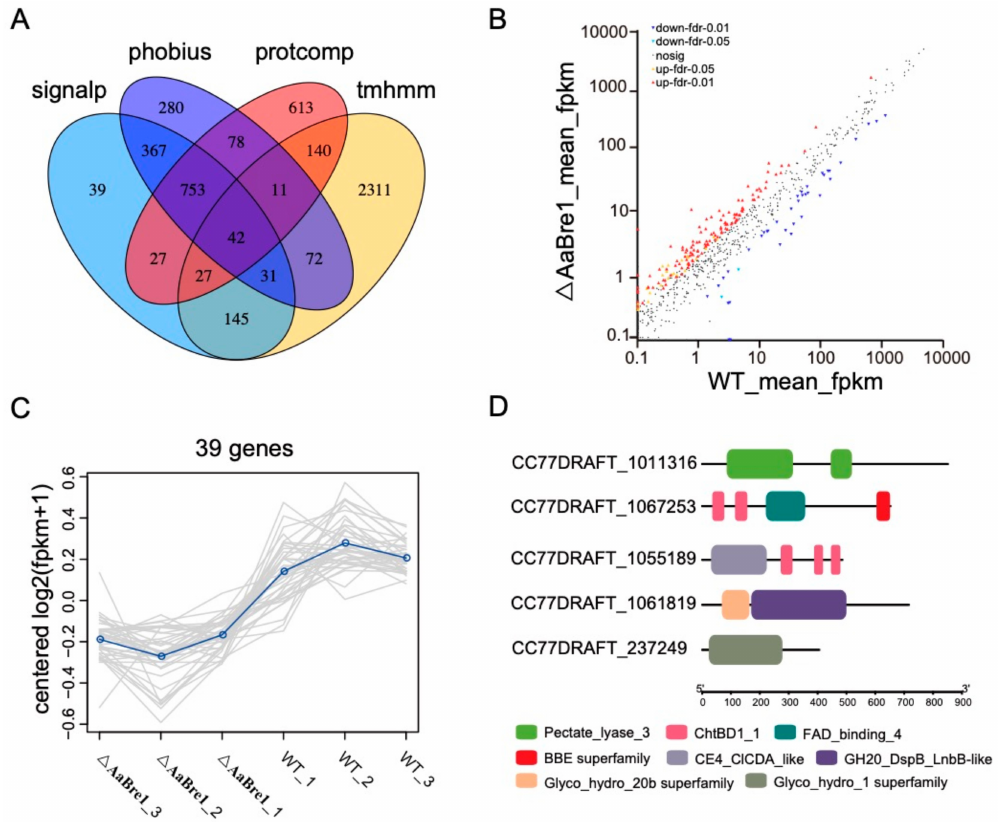
Figure 9. Expression analysis of secreted protein e ff ectors between WT and ∆ AaBre1. ( A ) Identification of the secreted proteins e ff ectors in A. alternata genome. ( B ) Scatter plot of di ff erent expressed secreted protein e ff ectors between WT and ∆ AaBre1. ( C ) Sub-cluster of down-regulated secreted protein e ff ectors. ( D ) Domain analysis of the down-regulated secreted protein e ff